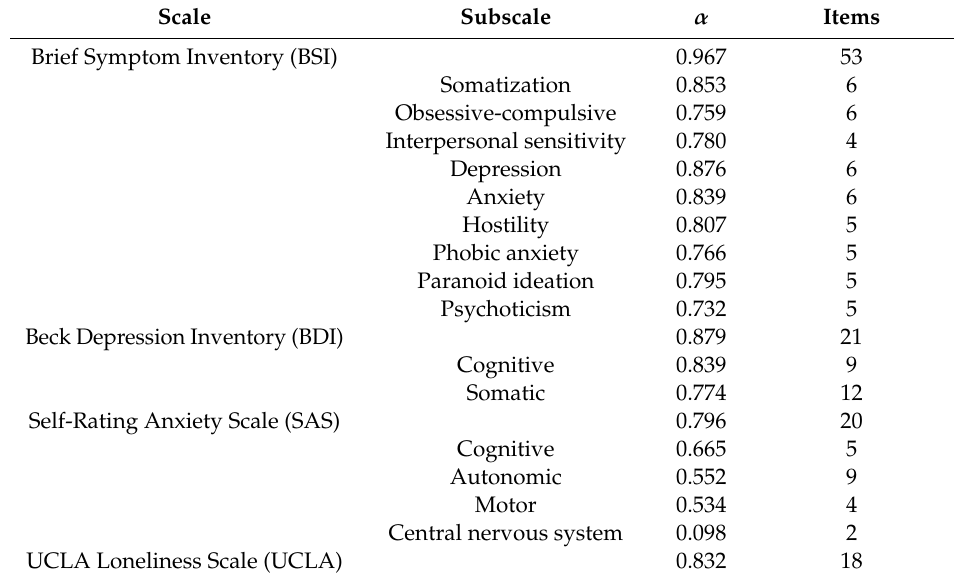
Table 3. Alpha Cronbach ( α ) results for scales and subscales.